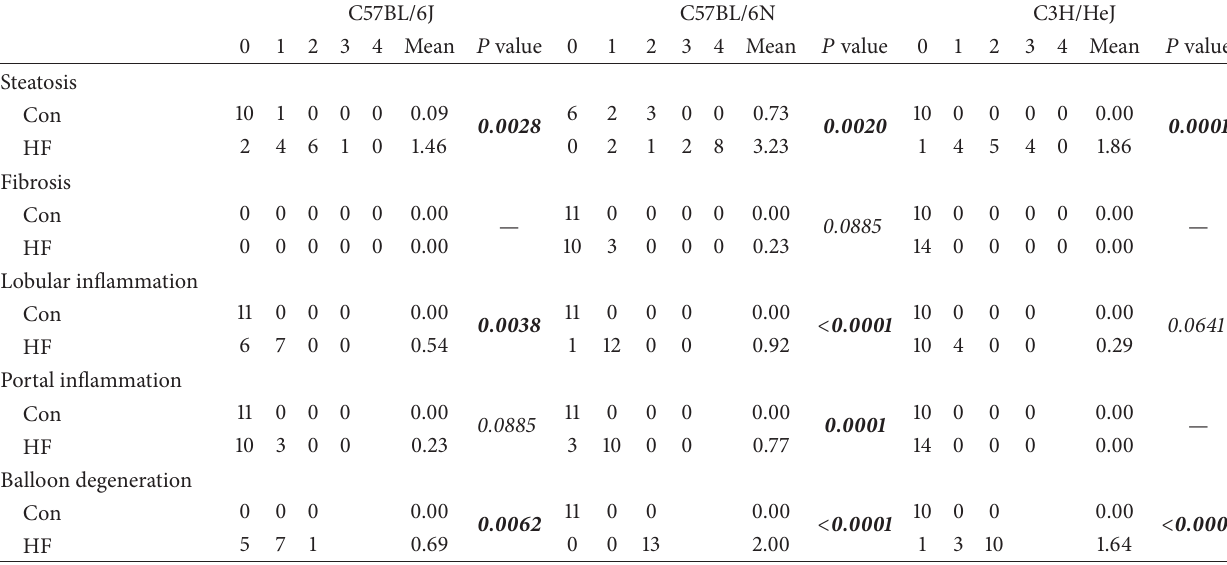
Table 2: Pathological scoring of hepatic tissue after 24 wk on a control or high fat diet.